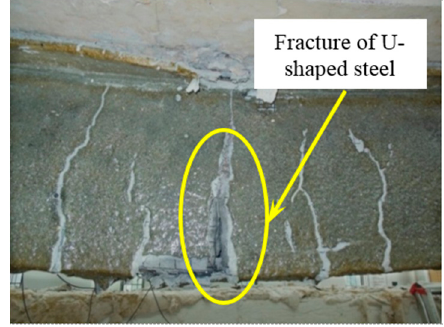
Figure 11. Fracture of U-shaped steel of Specimen B5.